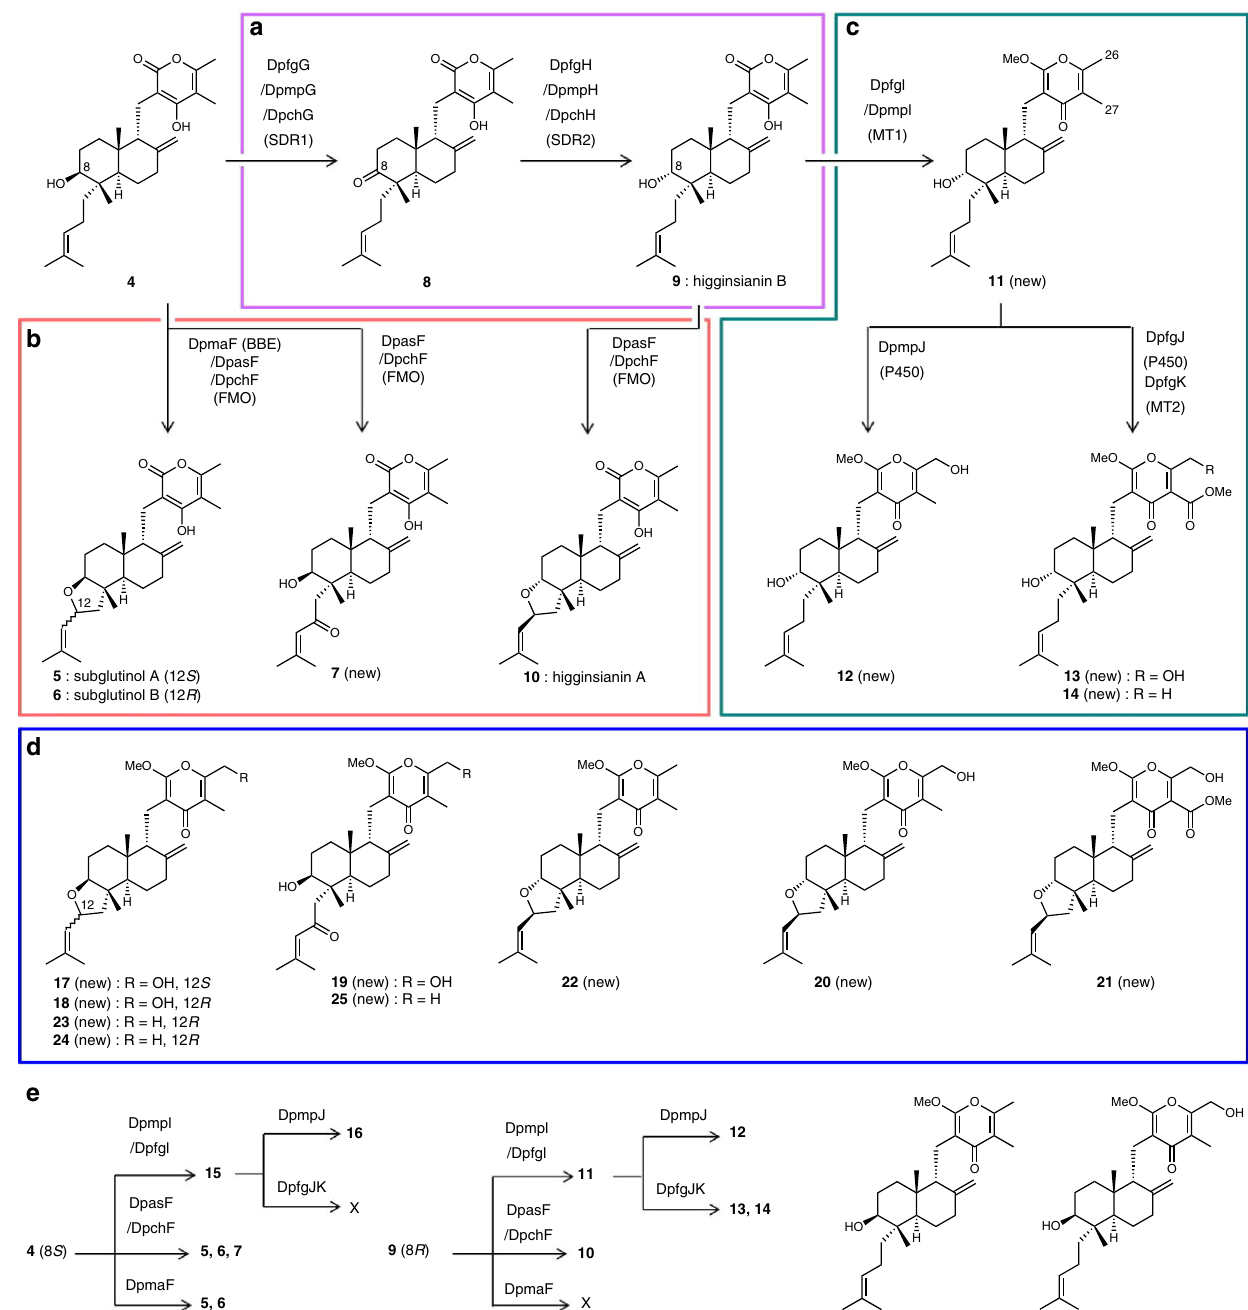
Fig. 4 Summary of enzymatic conversions in the DDP pathways. a C-8 stereochemistry inversion steps. b Modi fi cations at the C 5 unit. c Modi fi cations on the pyrone rings. d Structures of additionally modi fi ed DDPs produced through the extended pathways. e Summary of substrate selectivities of the modi fi cation steps in the DDP